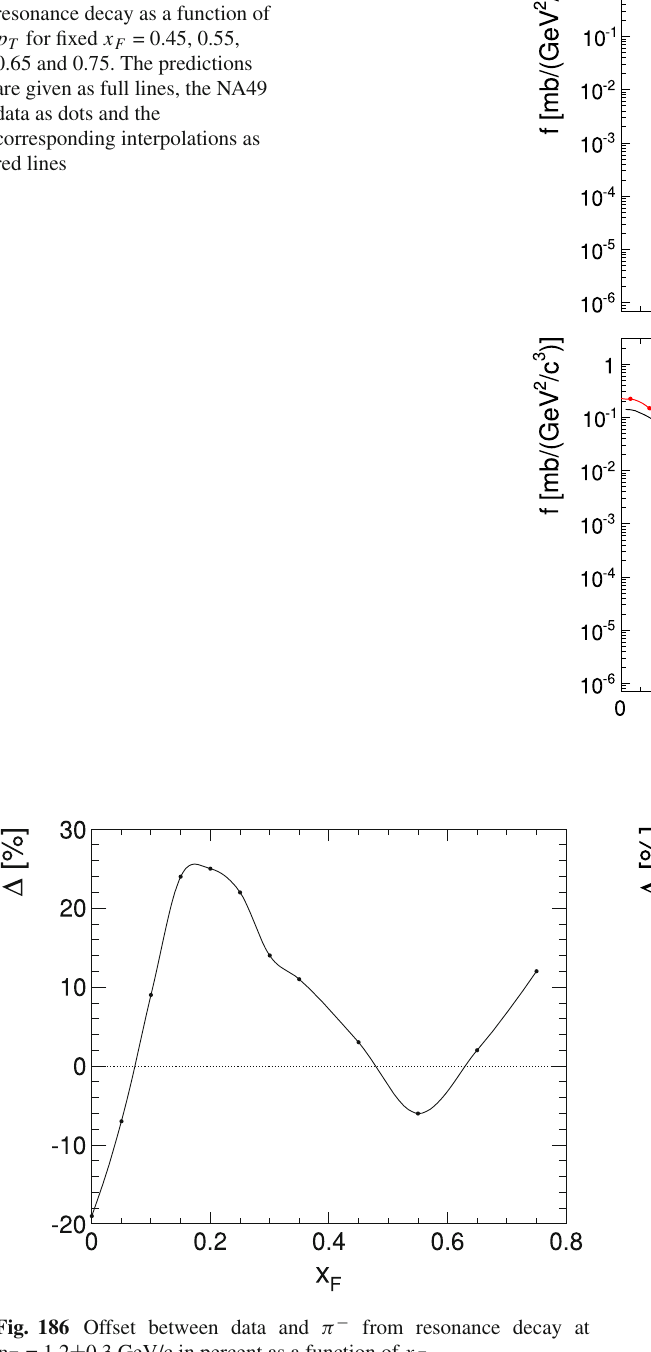
4. The increase with x F shows a maximum at x F ∼ 0.3 – 0.4 and decreases strongly towards higher x F